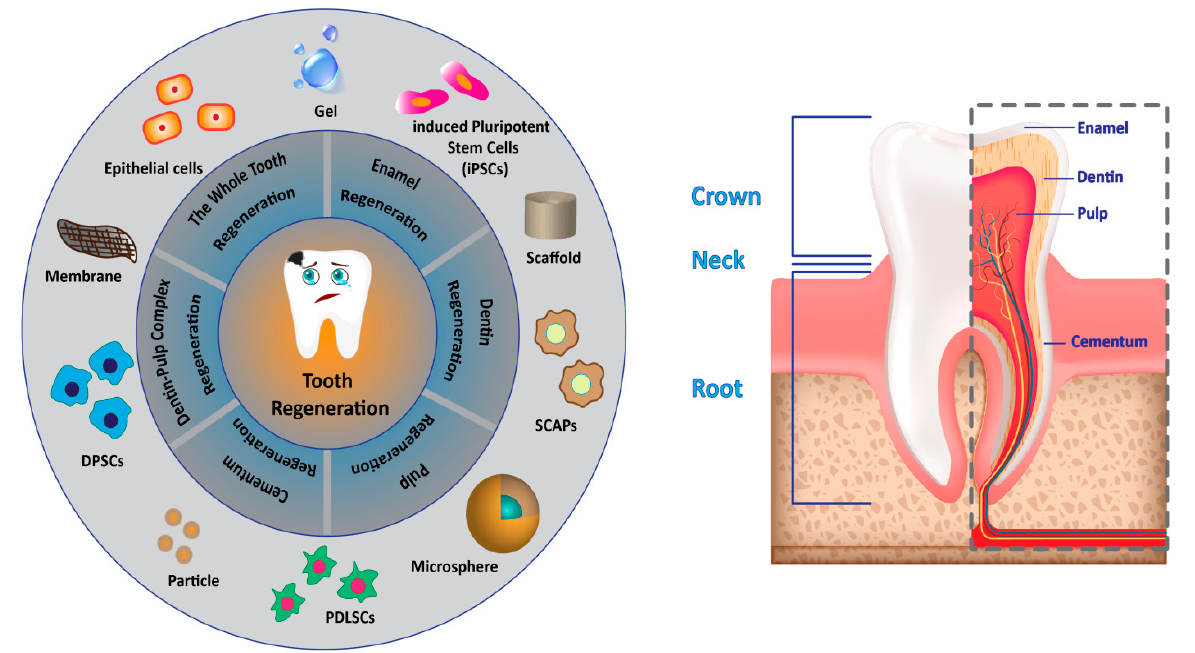
Figure 4. A graph showing tooth tissue regeneration based on cells and materials, including its structure.